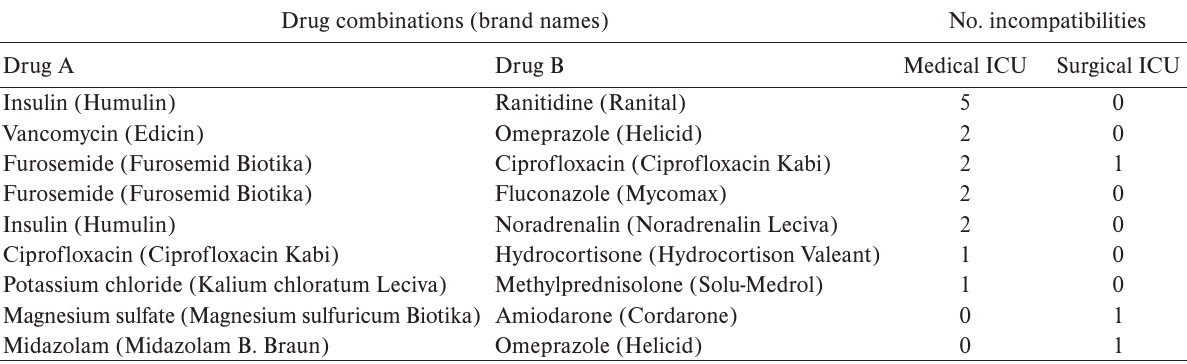
Table 2. Incompatible drug pairs coinfused through a common IV